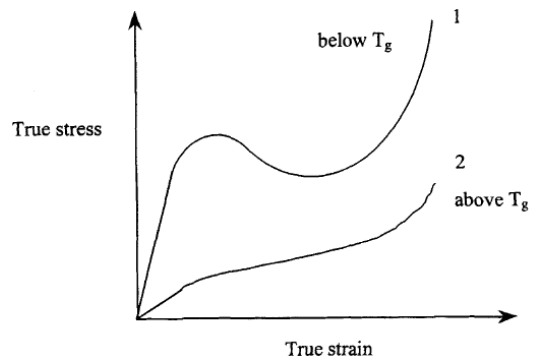
Fig. 1 Typical stress-strain relation of amorphous polymers (Figure from Juang et al.,